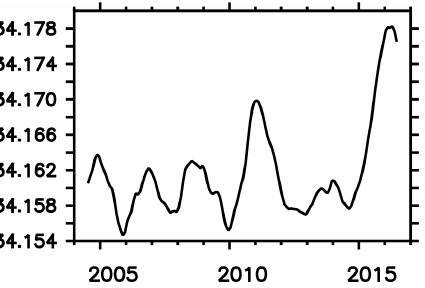
Figure 17. Simulated sea surface salinity averaged over the South- ern Ocean (i.e., south of 40 ◦ S) for the nominal years 1980–2024. The black (red) line refers to the reference (increasing wind) simu- lation.